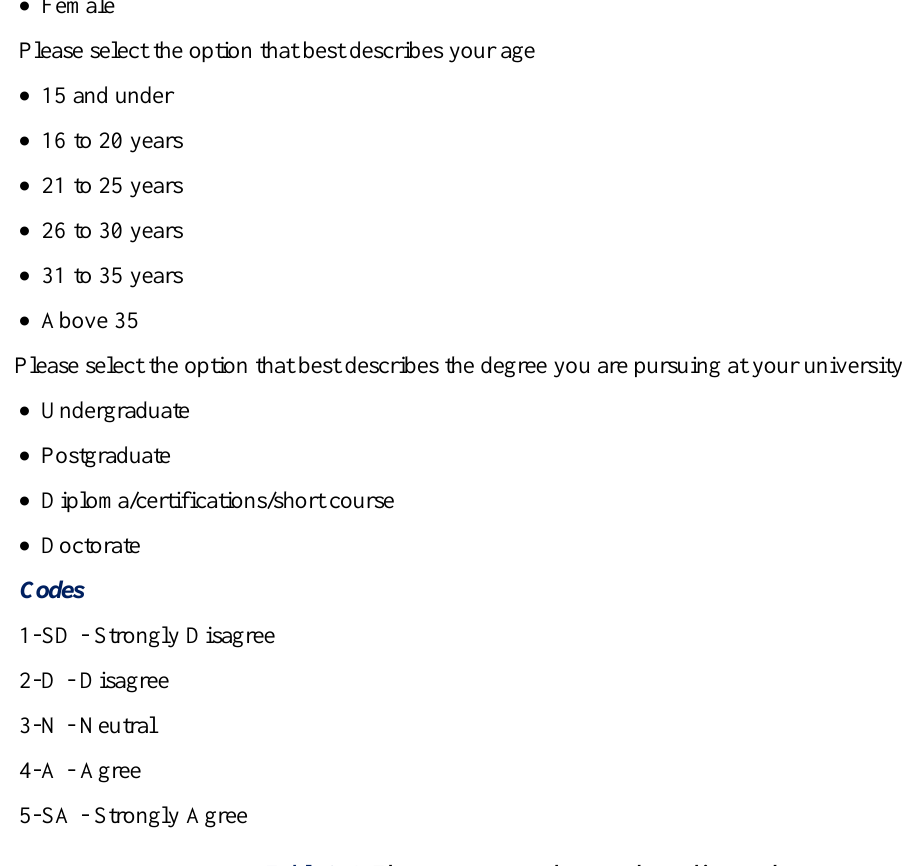
Table A-1. The statements and scores depending on the responses